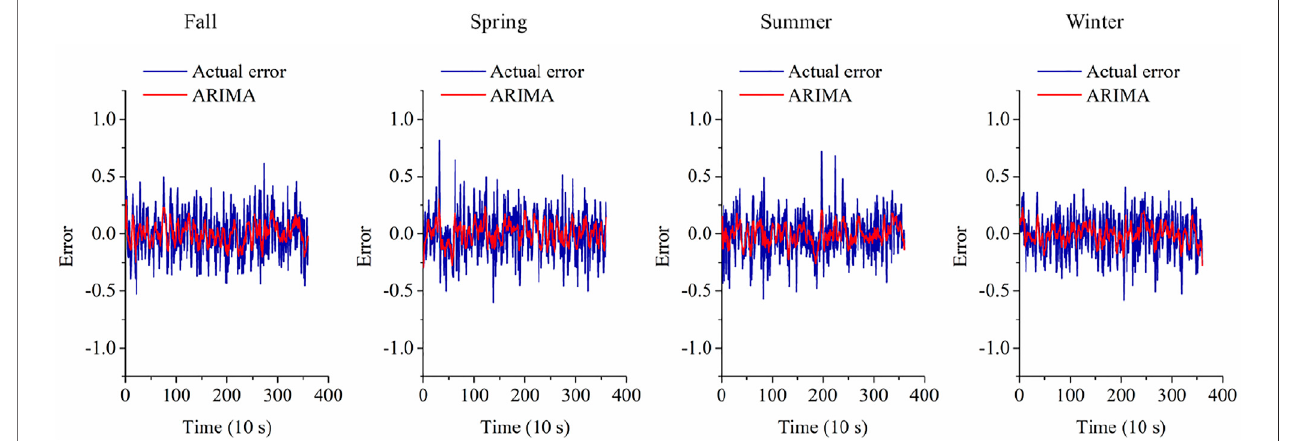
FIGURE 7 | Actual error versus forecasted error by ARIMA